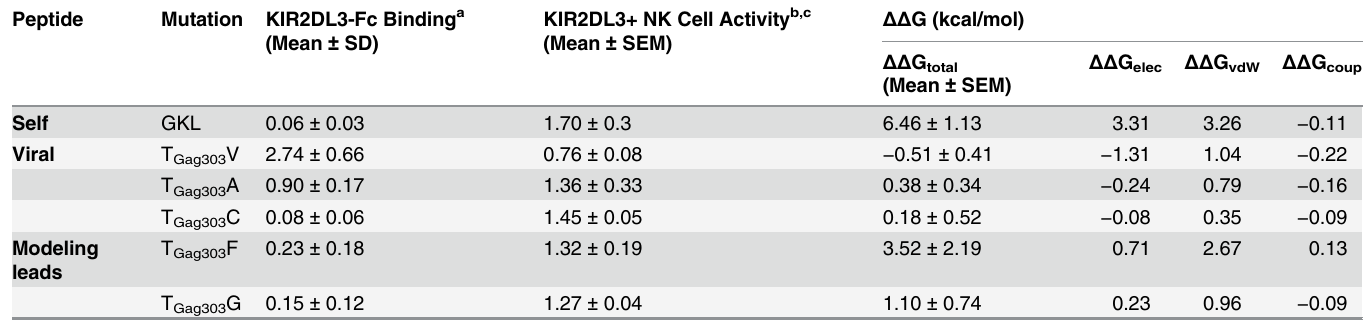
Table 2. Experimental validation of modeling